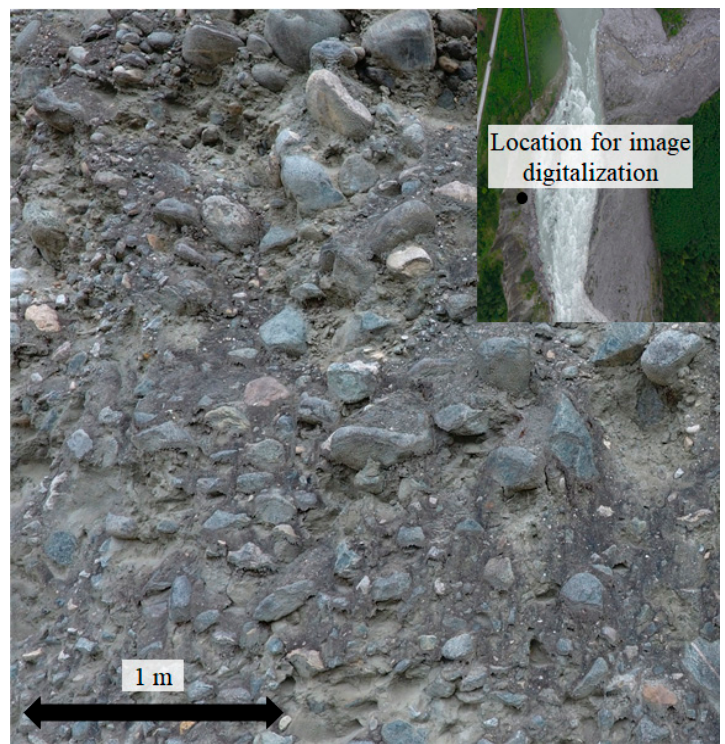
Figure 3. Riverbank soil from the Parlung Tsangpo River: image of the particles.